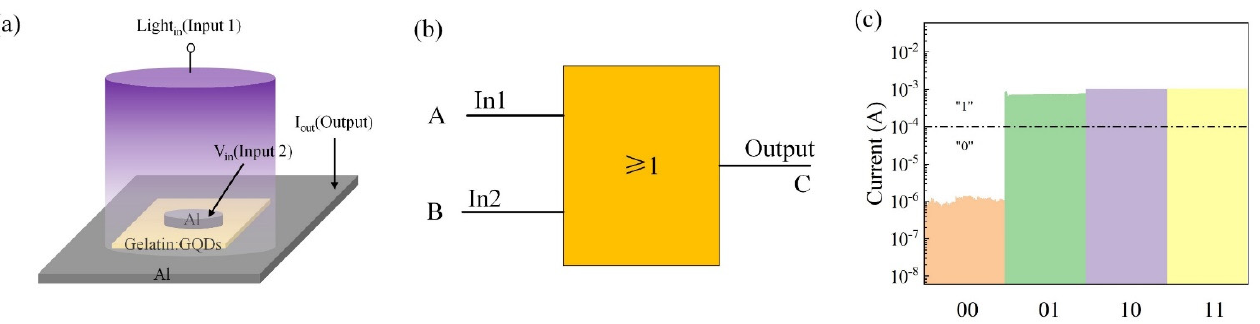
Figure 4. ( a ) Schematic diagram of applying UV light. ( b ) “OR” gate symbol. ( c ) Current response of the unit device under the action of photoelectric and electrical signals. Table 1. Data of Current response of the unit device under the action of photoelectric and electrical signals. Input Output Opt. Ele. Current (A) Logic